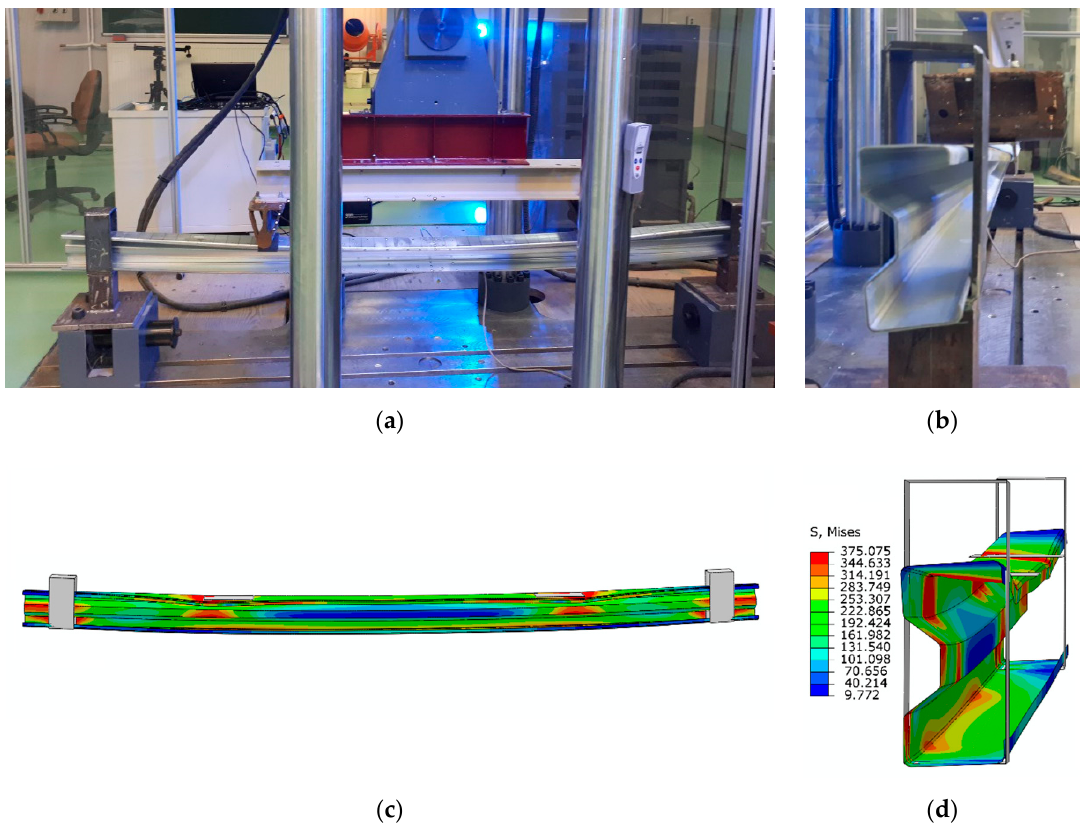
Figure 15. Comparison of beam Mises strains during laboratory tests and numerical analyses: ( a ) EXP (front side), ( b ) EXP (cross-section), ( c ) FEM (front side), ( d ) FEM (cross-section).